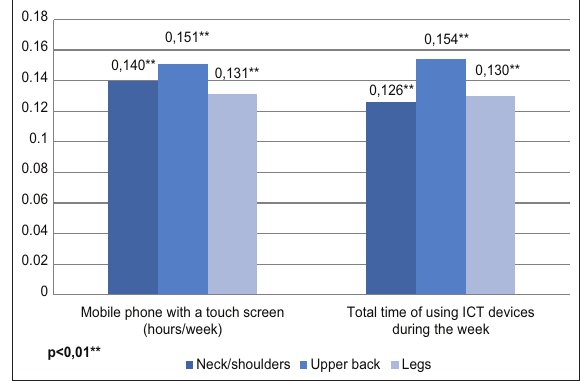
GRAPH 1. Correlation analysis of the frequency of pain in the past month of statistically significant variables in relation to the time of using ICT